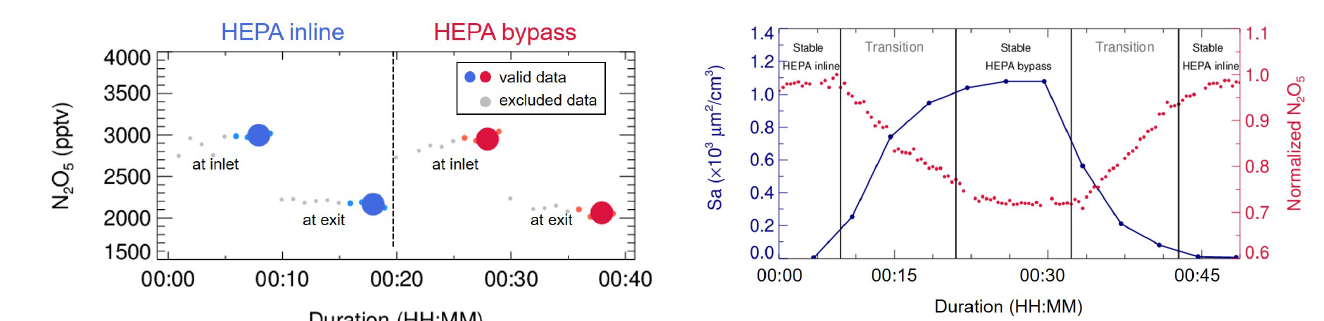
Figure 3. An exemplary case of measured N 2 O 5 concentrations within a duty cycle. This case was observed on the night of 13 De- cember 2020, with average ambient S a of 320µm 2 cm − 3 . The de- rived k wall of N 2 O 5 and γ( N 2 O 5 ) was 0.0023s − 1 and 0.035, re- spectively. The blue dots indicate N 2 O 5 concentrations measured under the HEPA inline mode, either at the inlet or exit of the flow tube (denoted as texts); the respective averages (blue dots of larger size) are used for deriving k wall (blue square). The red dots indi- cate N 2 O 5 concentrations measured under the HEPA bypass mode, either at the inlet or exit of the flow tube; the respective averages (red dots of larger size) are used for deriving the overall rate con- stant of N 2 O 5 loss on the wall and aerosols. The data points in gray are excluded from calculation due to unstable conditions in the flow tube.